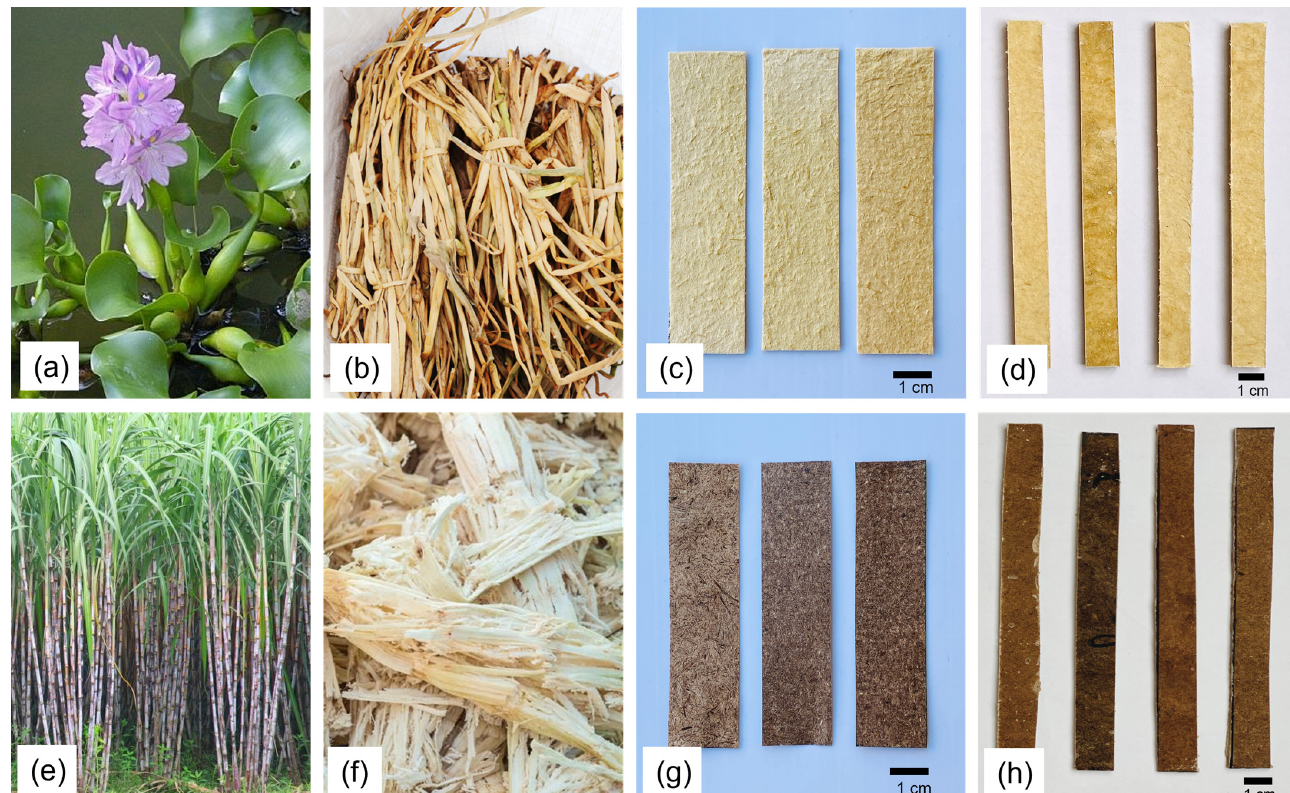
Figure 2. ( a ) Water hyacinth plant, ( b ) dry water hyacinth petiole, ( c ) water hyacinth nonwovens, ( d) water hyacinth nonwoven reinforced composite specimens for tensile test, ( e ) sugarcane plant, ( f ) dry sugarcane bagasse, ( g ) sugarcane bagasse nonwovens and ( h ) sugarcane bagasse nonwoven reinforced composite specimens for tensile test.